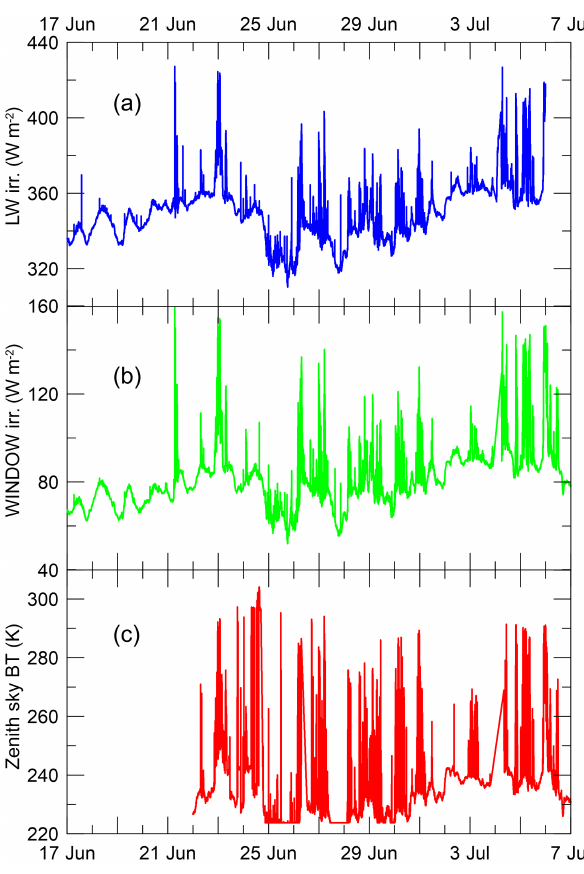
Figure 2. Time evolution of (a) the downward broadband LW ir- radiance, (b) the WINDOW irradiance, and (c) the zenith sky BT during the ADRIMED